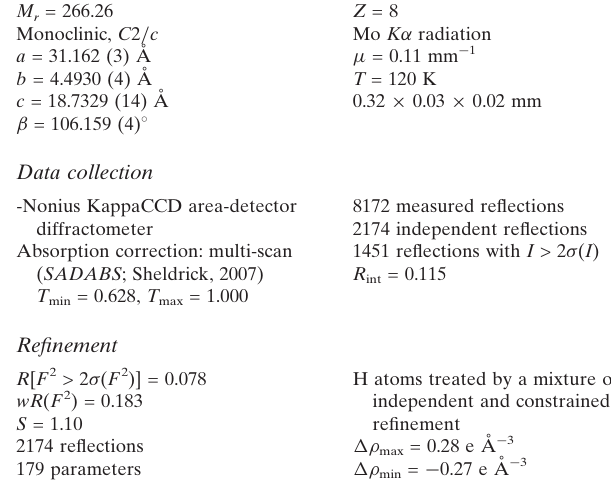
8172 measured reflections 2174 independent reflections